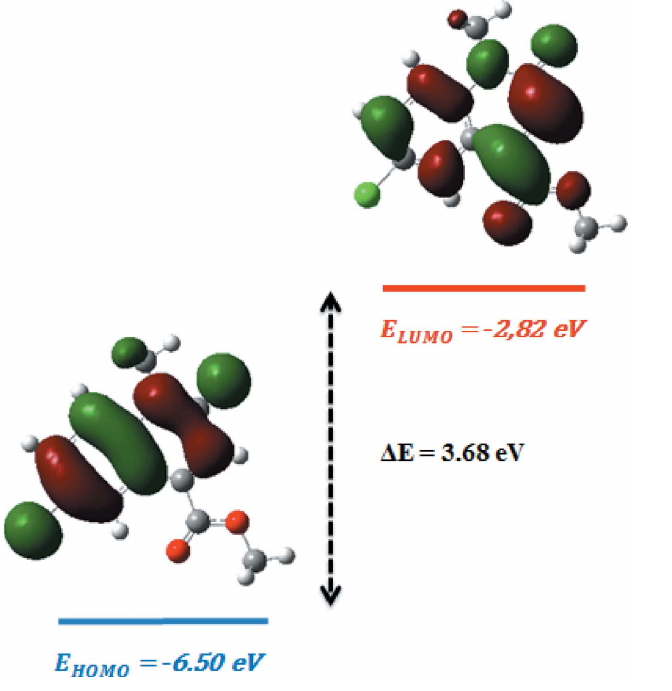
Figure 9 Contour surface of the electrostatic potential of